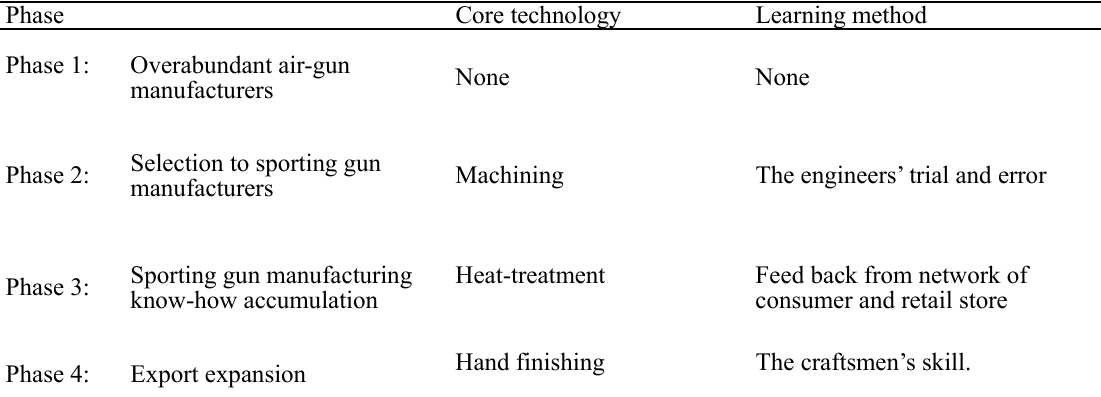
Figure 2. Four Phases and Core Technologies of Technology Learning